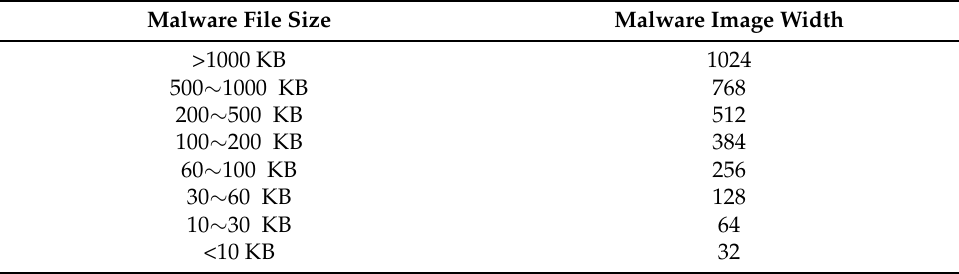
Table 3. Various malware image widths for different malware files’